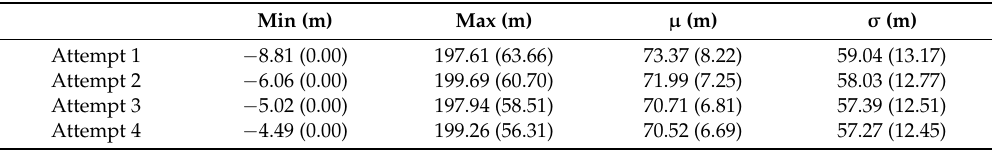
Table 6. Results of the flight path deviation for the SITL experiment with a 10 m/s UAV